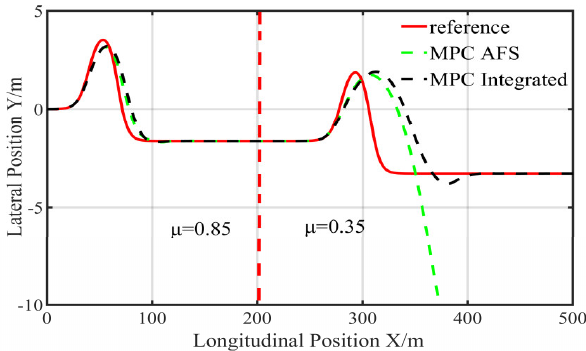
Figure 8. Comparison between the actual and reference paths at lower speed ( 80km/h A comparison graph between the heading angle and front wheel angle is shown in Figure 9 and that between the longitudinal velocity and the yaw rate is shown in Figure